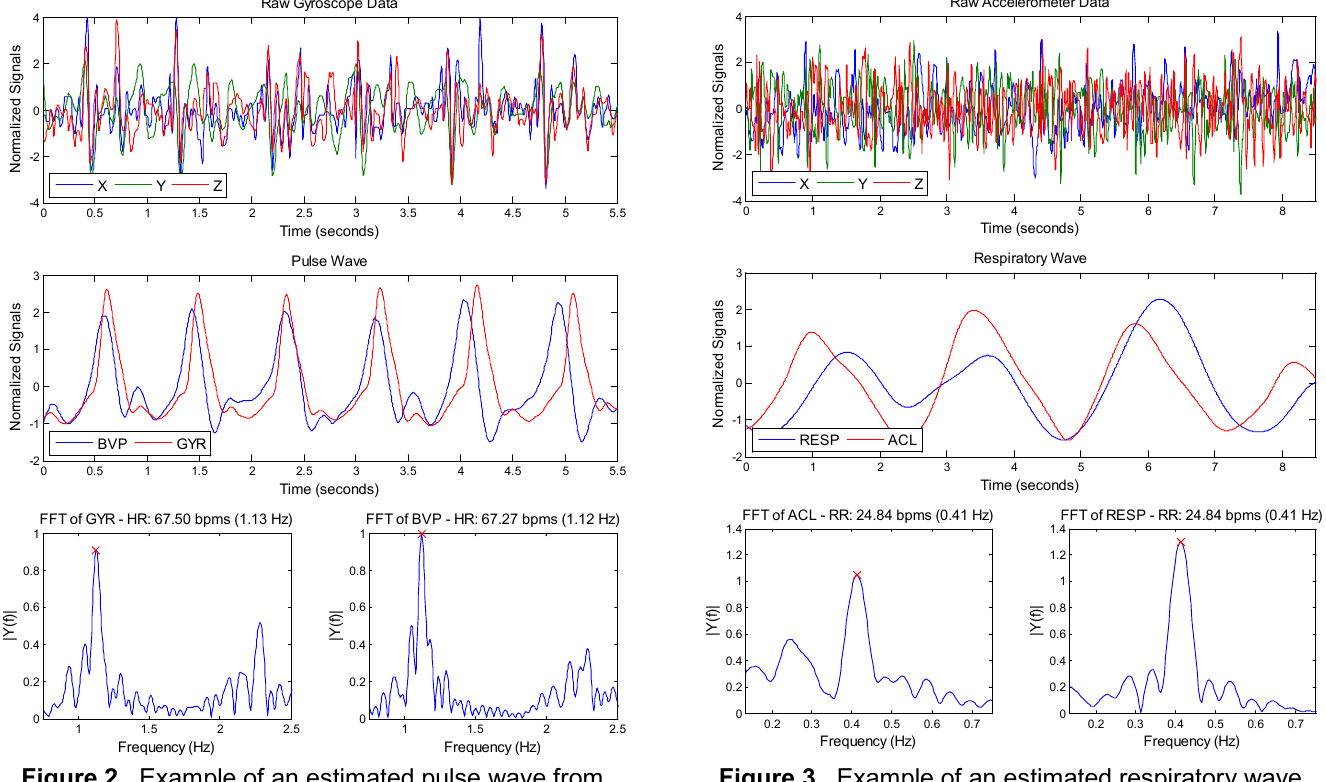
Figure 2 . Example of an estimated pulse wave from Figure 3. Example of an estimated respiratory wave gyroscope data (red) and the ground truth blood volume from accelerometer data (blue) and the ground truth respiration signal (red). Bottom graphs show the Fourier pulse signal (blue). Bottom graphs show the Fourier Spectrum of each signal. (FFT: Fourier Spectrum, Spectrum of each signal. (FFT: Fourier Spectrum, ACL: accelerometer, RESP: Respiration from chest GYR: Gyroscope, BVP: Blood Volume Pulse, HR: Heart band, RR: respiration rate, bpms: breaths per Rate, bpms: beats per minute)